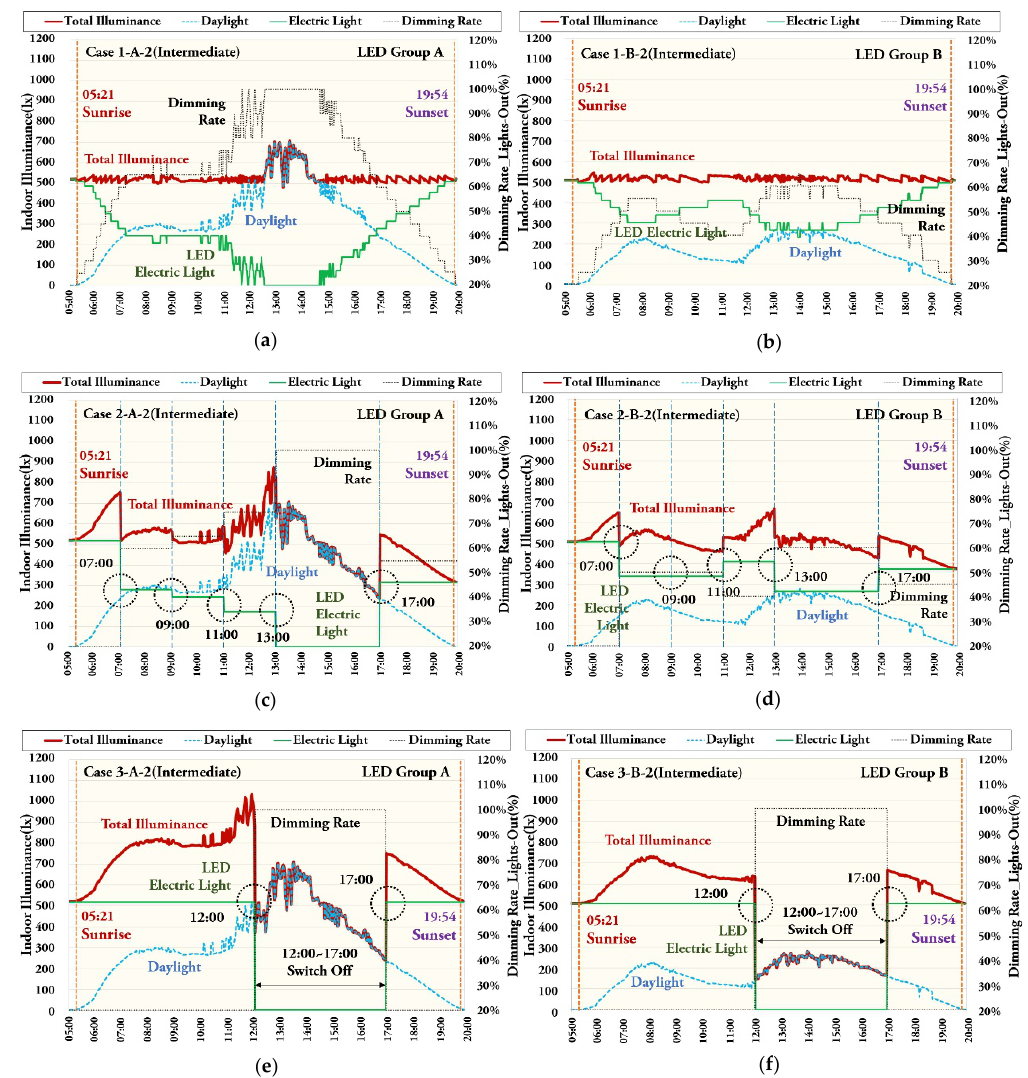
Figure 13. Illuminance and dimming rates under dimming control with no blinds (intermediate sky_07.24). ( a ) Case 1-A-2, ( b ) Case 1-B-2, ( c ) Case 2-A-2, ( d ) Case 2-B-2, ( e ) Case 3-A-2, and ( f ) Case 3-B-2 in Table